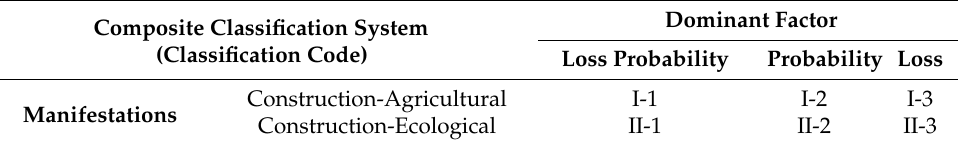
Table 3. Compound classification system for land-use spatial